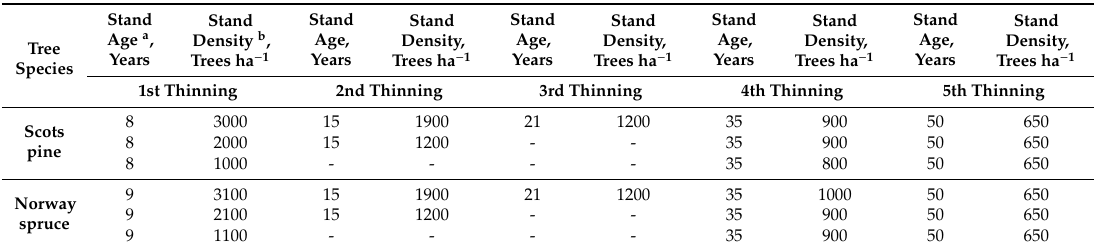
Table 1. Characteristics of the study plots chosen within the long-term experimental area established in 1990–1992 [33]. The characteristics given in the table include stand thinnings during the experiment of the full planned